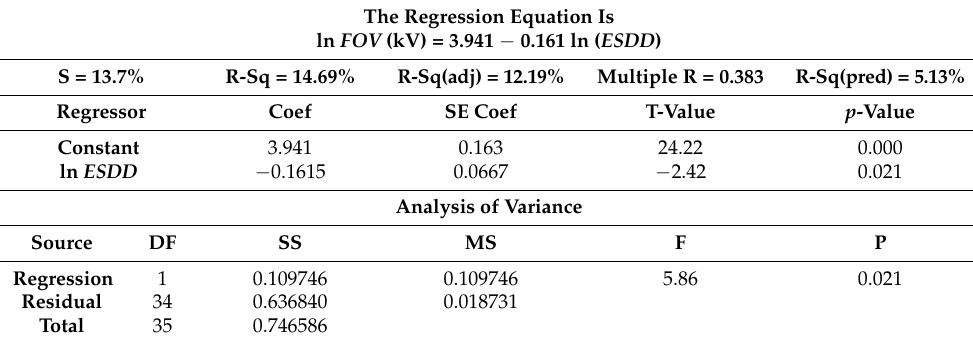
Table 2. Statistical results of ESDD -based model for both agricultural- and biological-polluted suspension